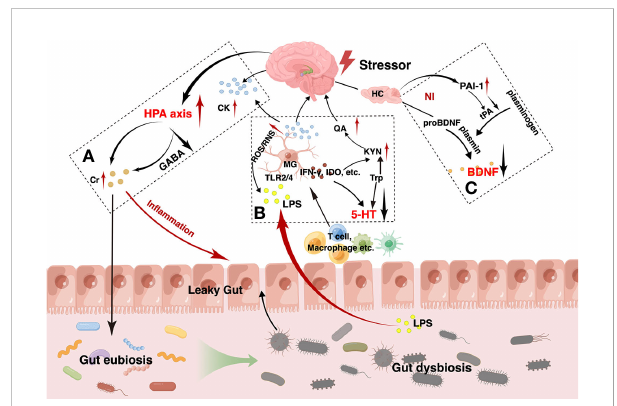
FIGURE 1 The main pathogenesis hypotheses for depression via the gut-brain axis. As shown, the hypothalamus-pituitary-adrenal (HPA) axis of the brain is activated by various stressors such as psychological stress and the increased pro-in fl ammatory cytokines (A) . Due to the disruption of the g-aminobutyric acid (GABA) negative feedback in depression, however, the HPA axis abnormally activated, leading to persistent elevation of cortisol. High level of cortisol contributes to peripheral in fl ammation and can disrupt the normal gut microbiota. Gut dysbiosis, in fl ammation and other factors in combination lead to impaired intestinal barrier function, called leaky gut, which manifests as increased intestinal permeability, decreased intestinal villi length and colonic crypts depth. Intestinal immune cells such as T cells, macrophages, and so on, and gram-negative bacteria-produced lipopolysaccharide (LPS) in the gut can translocate from gut into brain, which can act on the microglia and lead to neuroin fl ammation. In turn, the over-activated microglia can release amount of indoleamine 2,3-dioxygenase (IDO), interferon g (IFN- g ) and so on, resulting in a decrease in tryptophan metabolism to 5-hydroxytryptamine (5-HT) and an increase in the neurotoxic kynurenine, quinolinic acid (B) . Meanwhile, neuroin fl ammation can reduce the level of brain-derived neurotrophic factor (BDNF) that is produced in the atrophied hippocampus and prefrontal cortex. Abnormally reduced plasminogen activator inhibitor-1 (PAI-1) is also considered as a possible causative agent (C) . All these factors interact with each other and contribute to the onset and worsening of